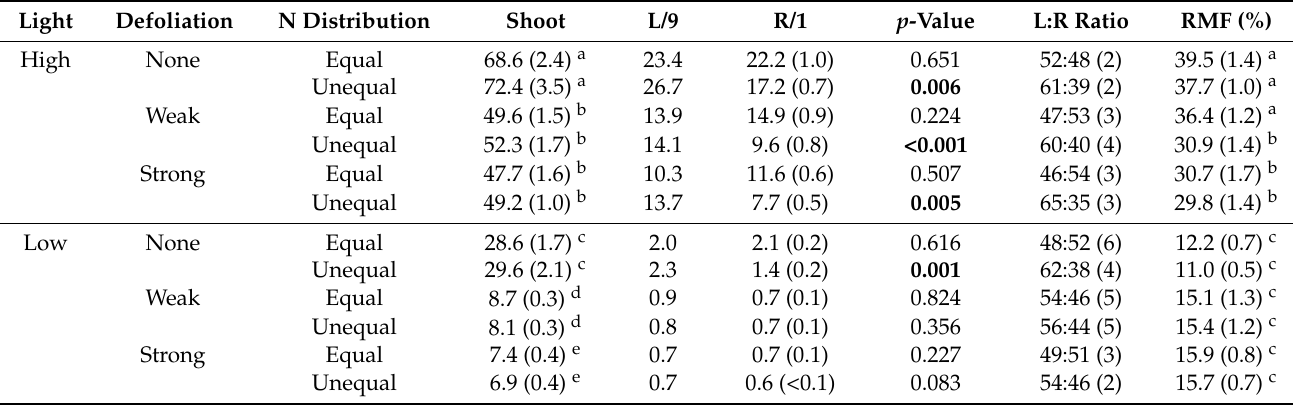
Table 1. Effect of strong (every 2 days) or weak (every 6 days) defoliation on the shoot and root mass (mg) in Poa annua plants grown under high and low light, where n = 12. In the plants supplied N equally, the roots are denoted as L and R, while in the plants supplied N unequally, they are denoted 9 and 1. The L:R ratio shows the distribution of roots between the two root box chambers. For shoot mass, different letters indicate statistically significant differences between groups. p -values represent paired comparisons between root masses in each split root box chamber. Bold letters represent statistically significant differences at p ≤